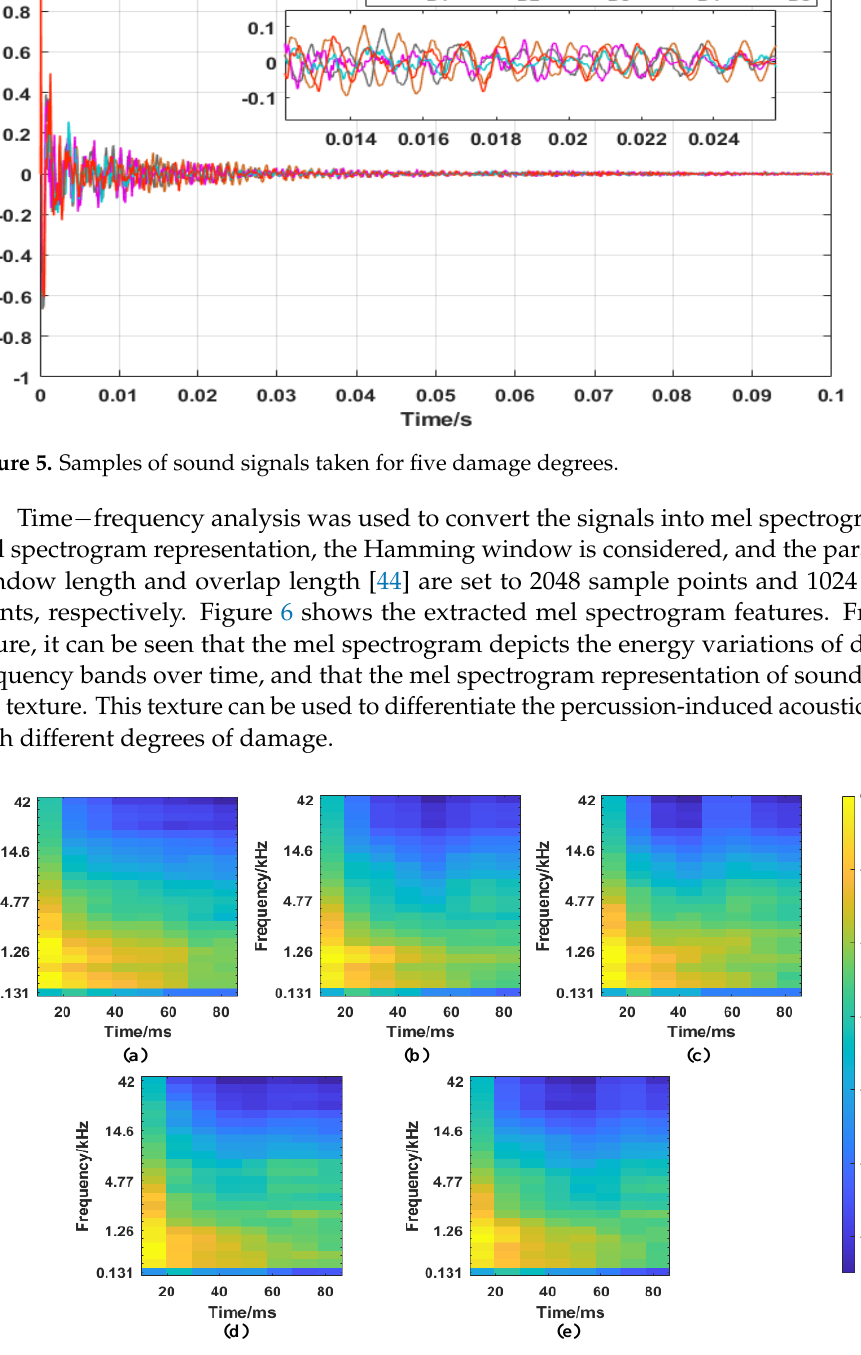
Figure 6. The mel spectrograms of selected signals: ( a ) D1, ( b ) D2, ( c ) D3, ( d ) D4 and ( e ) D5.